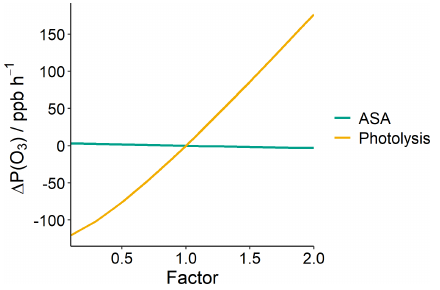
Figure 11. Impact of varying photolysis rates and ASA on mean modelled morning O 3 production rates, (cid:49)P( O 3 )